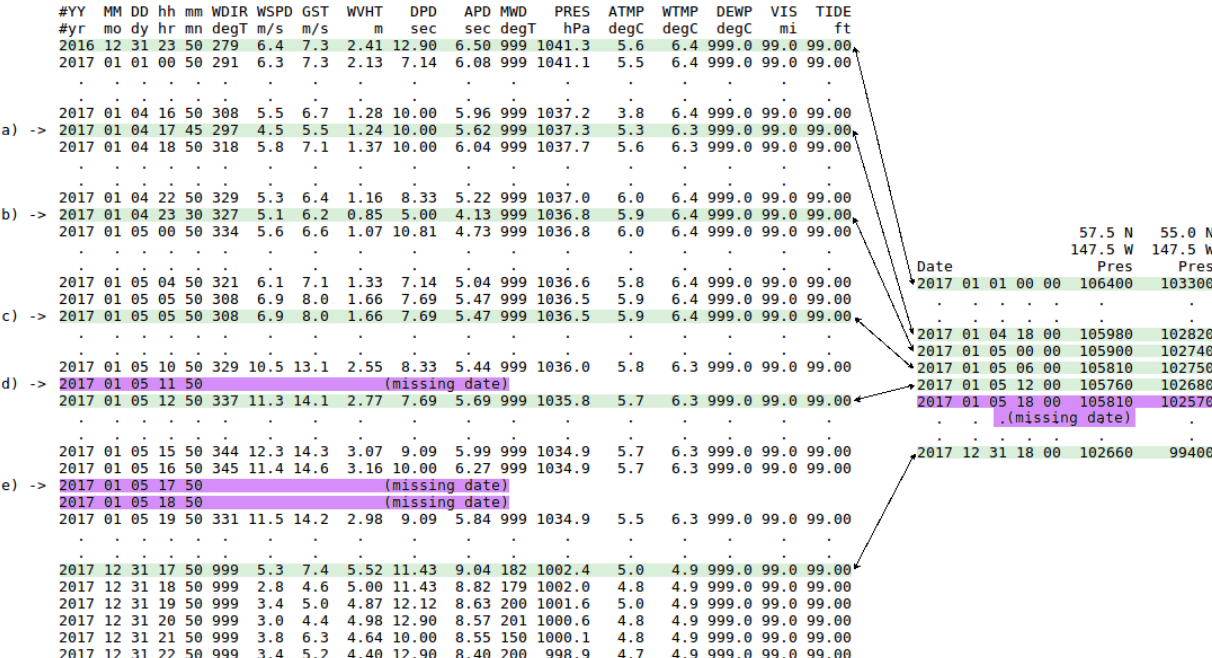
Figure A3. Matching the measurements ( left ) and the reanalysis data ( right